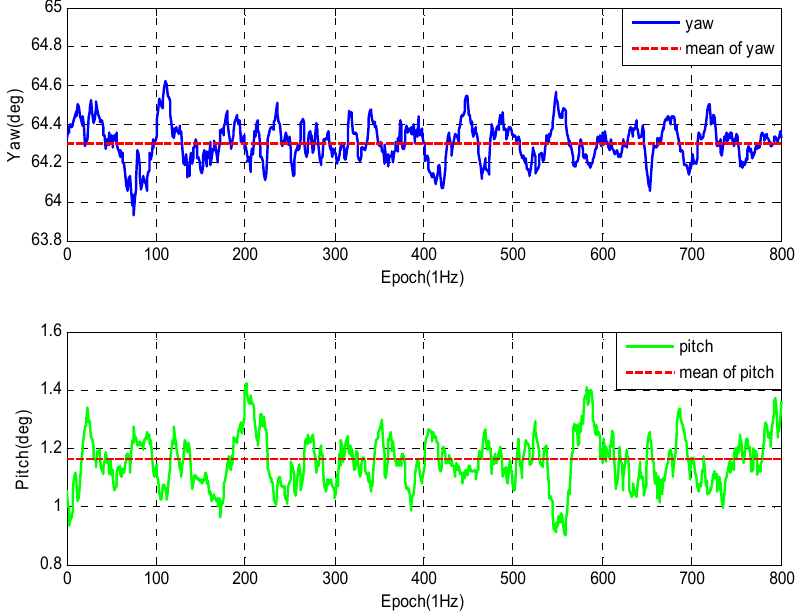
Figure 12. Experimental data of 1st group.